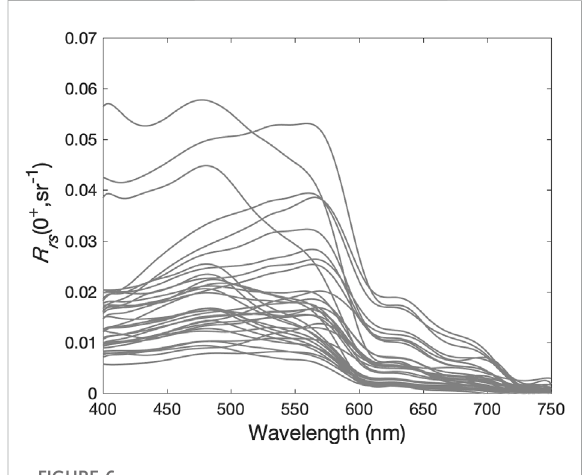
FIGURE 6 In situ hyperspectral remote sensing re fl ectance spectra ( R rs , sr − 1 ) collected in Abrolhos Bank in March 2013 and February 2016.